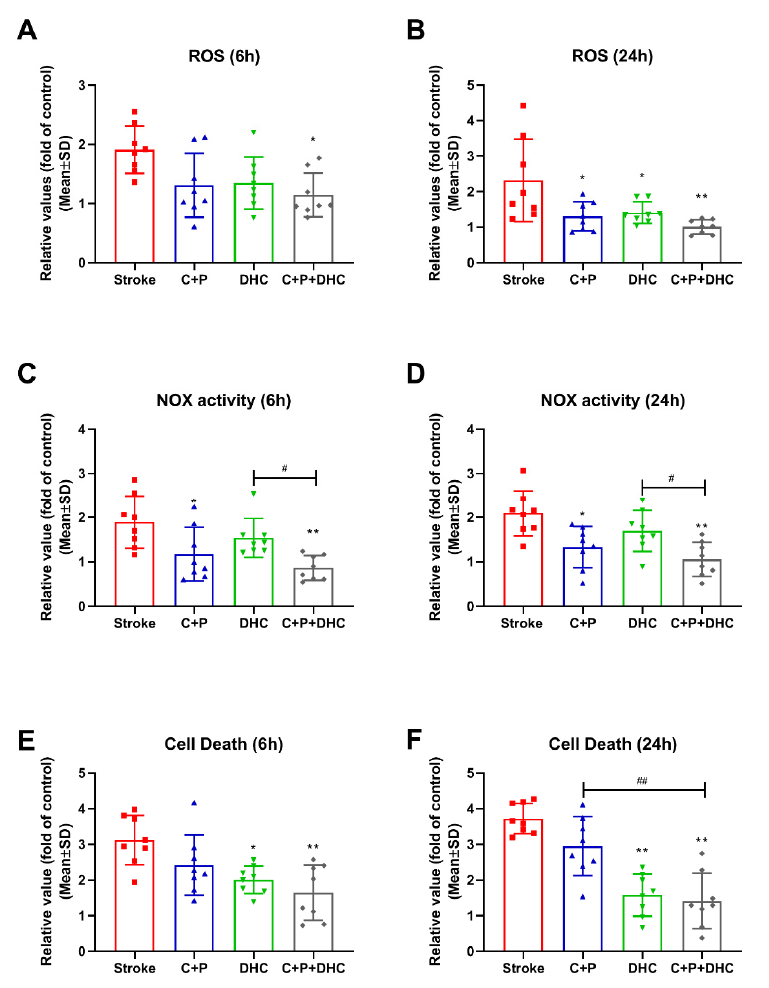
Figure 2. Effect of pharmacological hypothermia on ROS, NOX activity, and cell death in rats with 2 h MCAO. Stroke increased ROS levels, which was significantly reduced by the combination of C + P and DHC at both 6 ( A ) and 24 h ( B ) after reperfusion. C + P and DHC individually significantly reduced ROS levels at 24 h after reperfusion ( B ). NOX activity was significantly increased after stroke at 6 ( C ) and 24 h ( D ) of reperfusion, which was reversed by C + P, or the combination of C + P and DHC treatment. Apoptotic cell death significantly increased at 6 ( E ) and 24 h ( F ) of reperfusion. DHC and the combination of C + P and DHC significantly reduced cell death, while C + P alone did not. Data are presented as mean ± SD, * p < 0.05, ** p < 0.01, as compared to stroke group; # p <